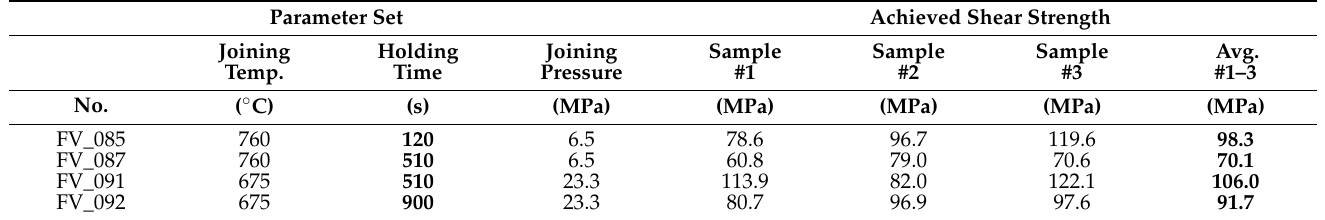
Table 6. Results of base material/paste combination IN 718_am + Ni90_T_KD4 with significant value changes highlighted